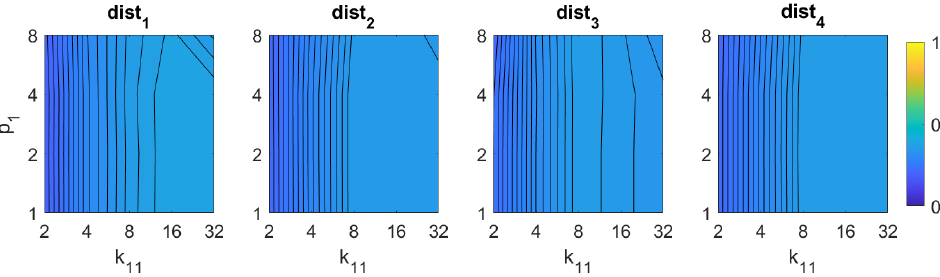
Figure 11. RT–F image retrieval problem. Success rate of the method. k 11 is the number of blocks and p 1 the relative angle (deg) between the lines in each set (Table